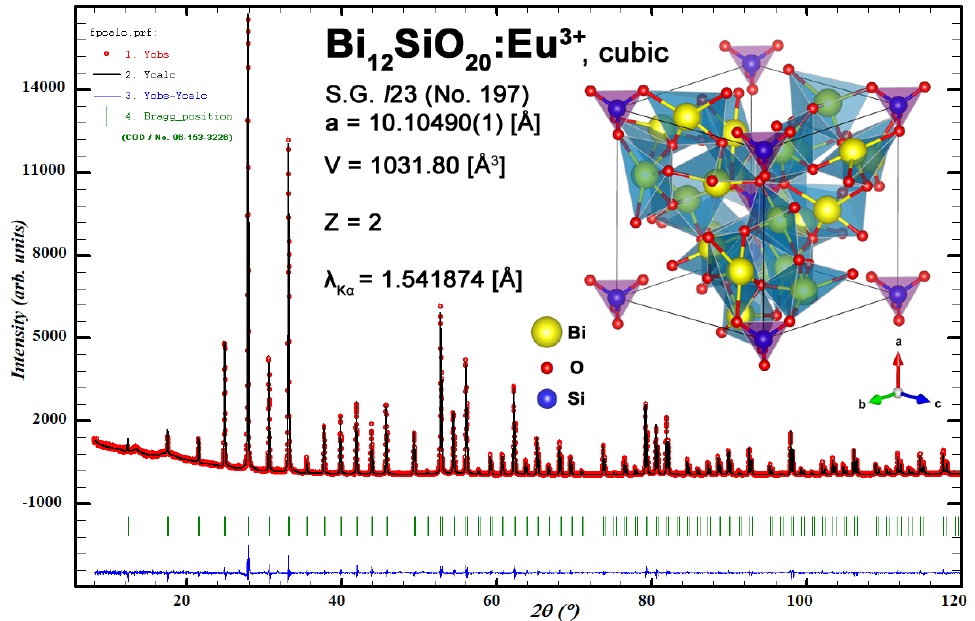
Figure A1. Experimental XRD powder diffraction pattern along with Rietveld refinement plot and refined structure of Bi 12 SiO 20 :Eu 3+ unit cell.